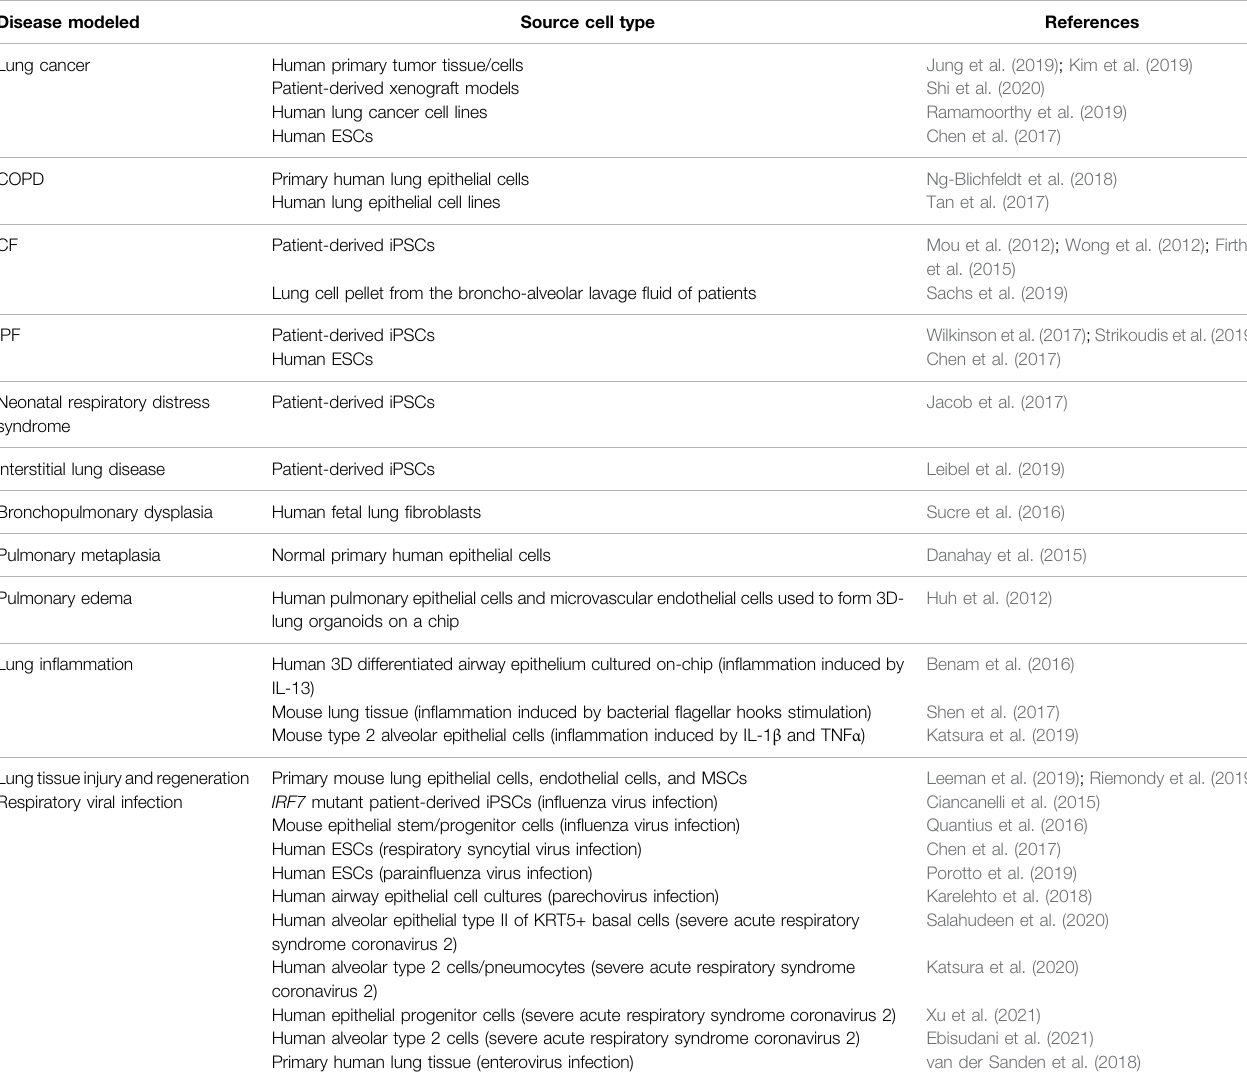
TABLE 1 | Lung organoids used for disease investigation: Disease studies where 3D LOs were used as experimental models. Disease